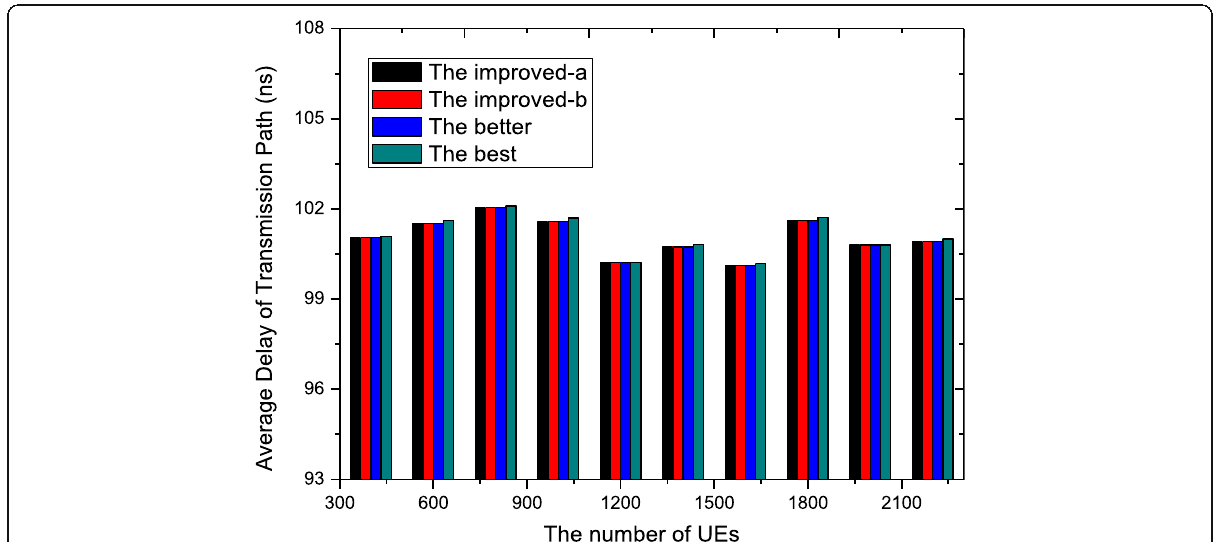
Fig. 10 Delay performance comparison: variation trend delay of TOM-PAOD with the number of UEs in the given region, in which the different game decision algorithms are adopted